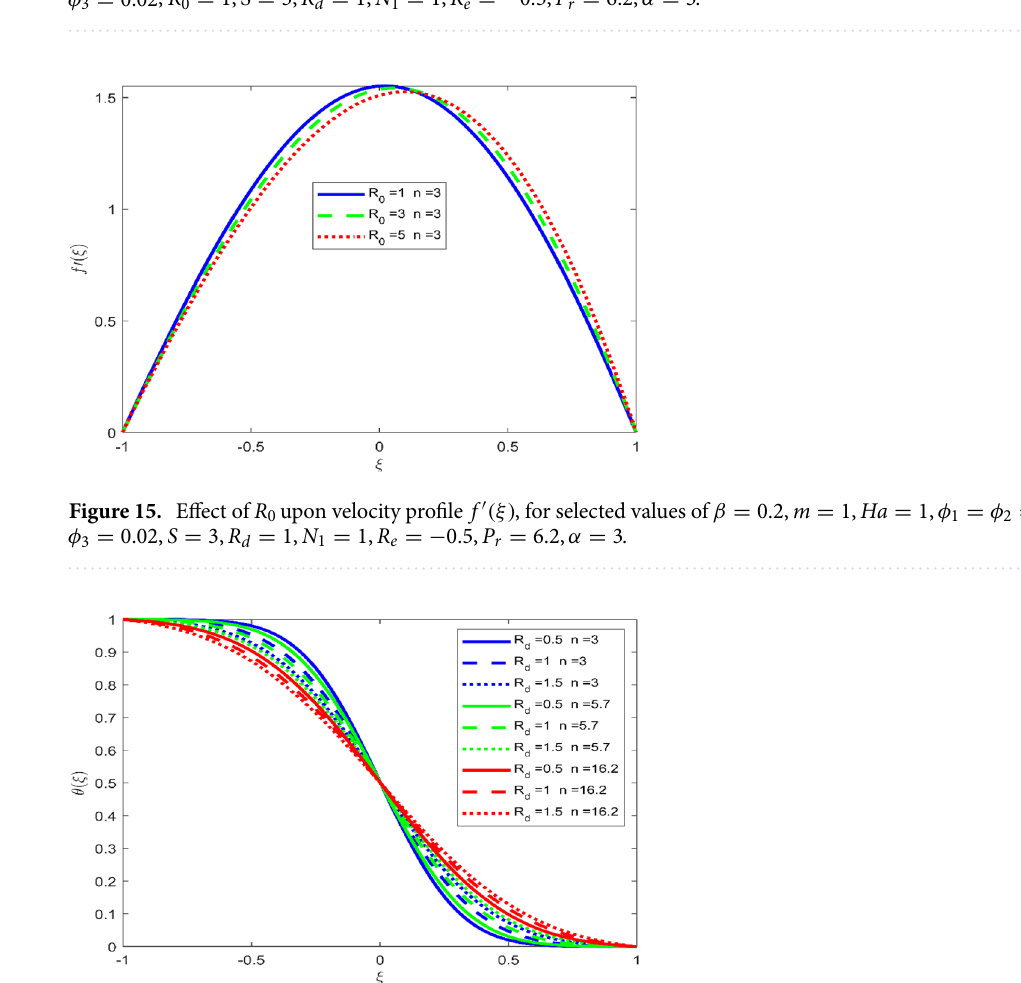
Figure 14. Effect of R 0 upon velocity profile H (ξ) , for selected values of β = 0.2, m = 1, Ha = 1, φ 1 = φ 2 =